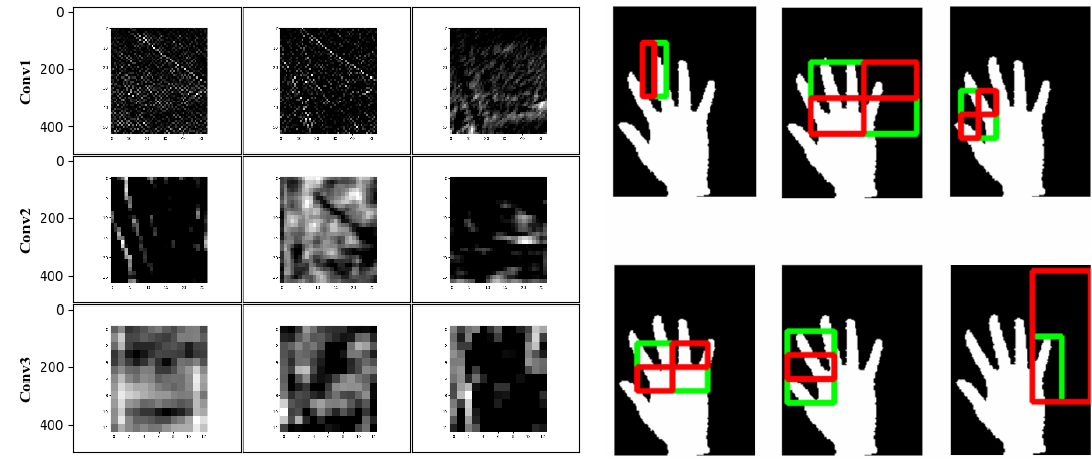
Figure 9. Comparison of learned features in our ROI extraction model with the Han method